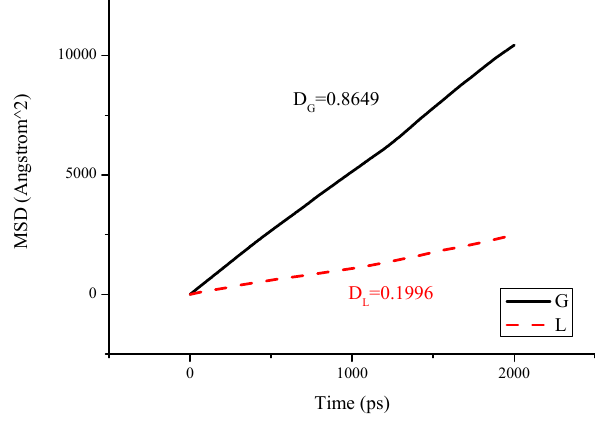
Figure 8. The mean square displacement of CH 4 molecules in the liquid and gas side.